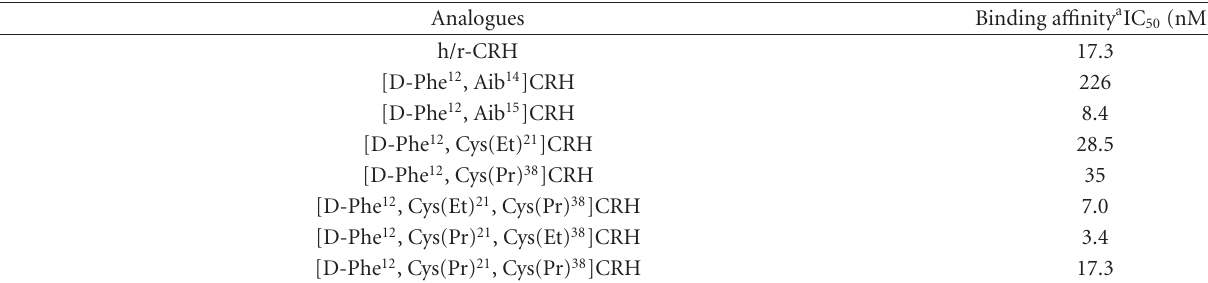
Table 3: Binding a ffi nities of h/r-CRH analogues.